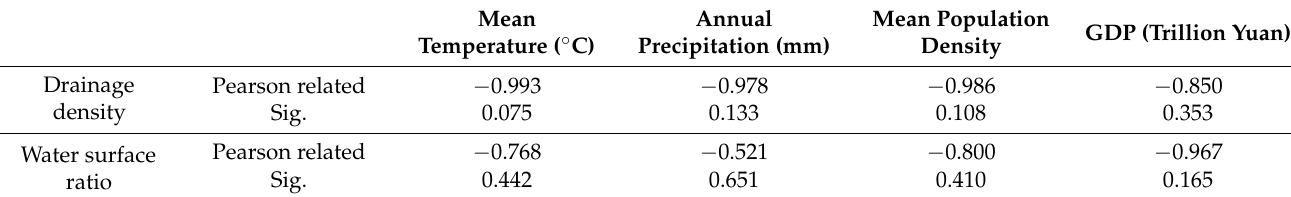
Table 6. Pearson correlation coefficients of drainage density with water surface ratio and four influencing factors. Mean Annual Mean Population GDP (Trillion Yuan) Temperature ( ◦ C) Precipitation (mm) Density Drainage Pearson related − density